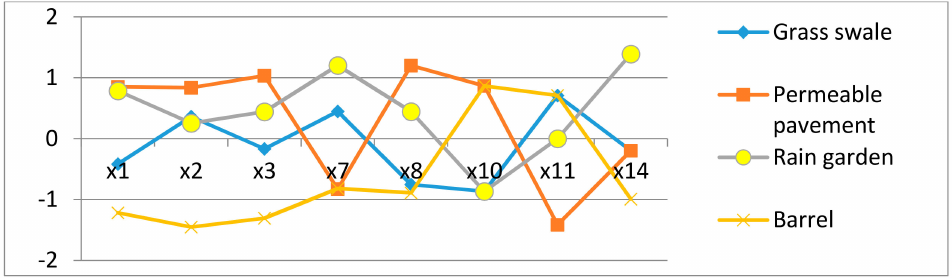
Figure 10. The line graph for the eight selected